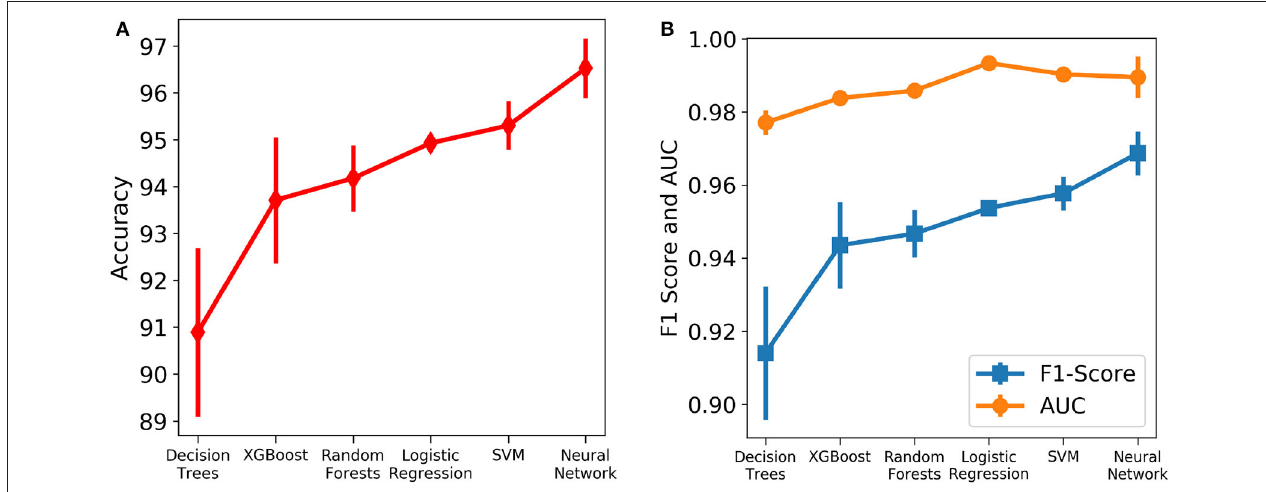
FIGURE 4 | Comparison of the performance of different machine learning algorithms assessed using different metrics. The vertical lines denote the standard deviations. (A) Accuracy. (B) AUC and F1 score.